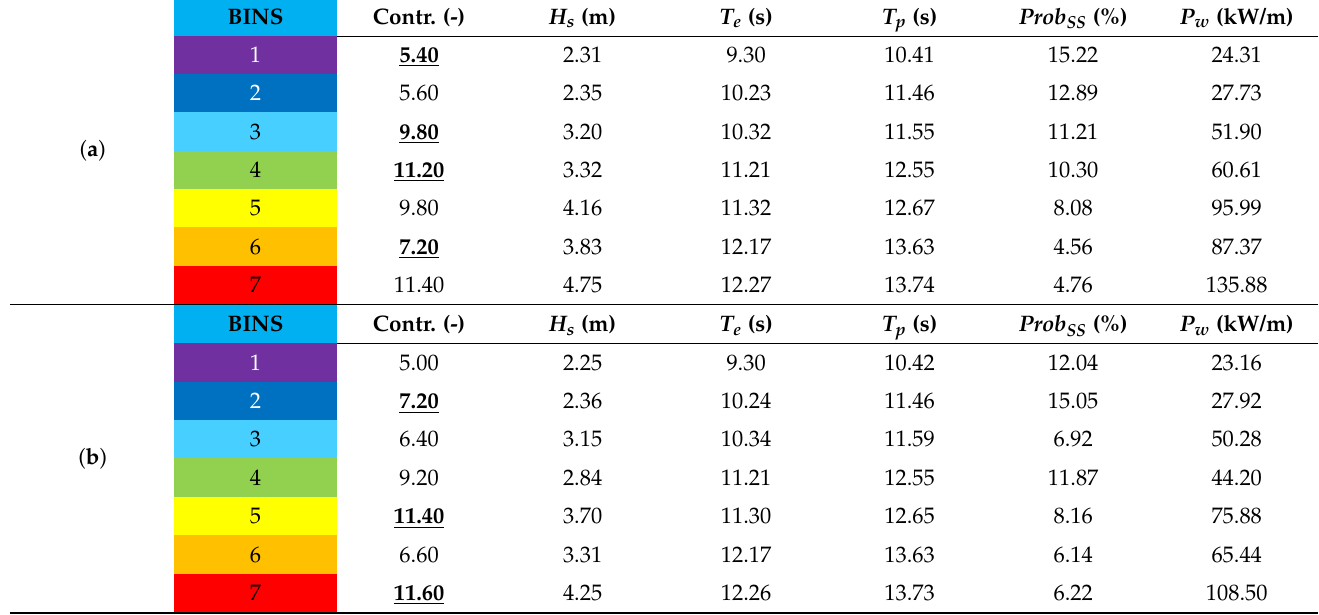
Figure 8. Bin distribution (one per group of four colours) for the case studies of ( a ) Aguçadoura and ( b ) São Pedro de Moel. Table 2. Representative bins from the ( a ) Aguçadoura and ( b ) S ã o Pedro de Moel case studies. Contr.